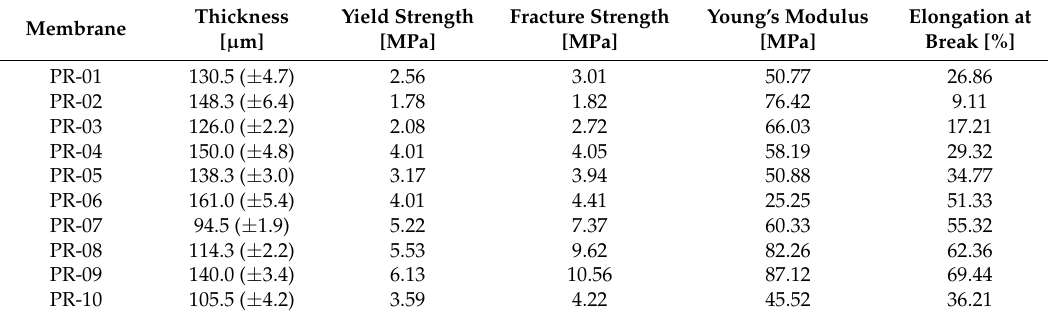
Table 3. Mechanical properties of blended PVDF